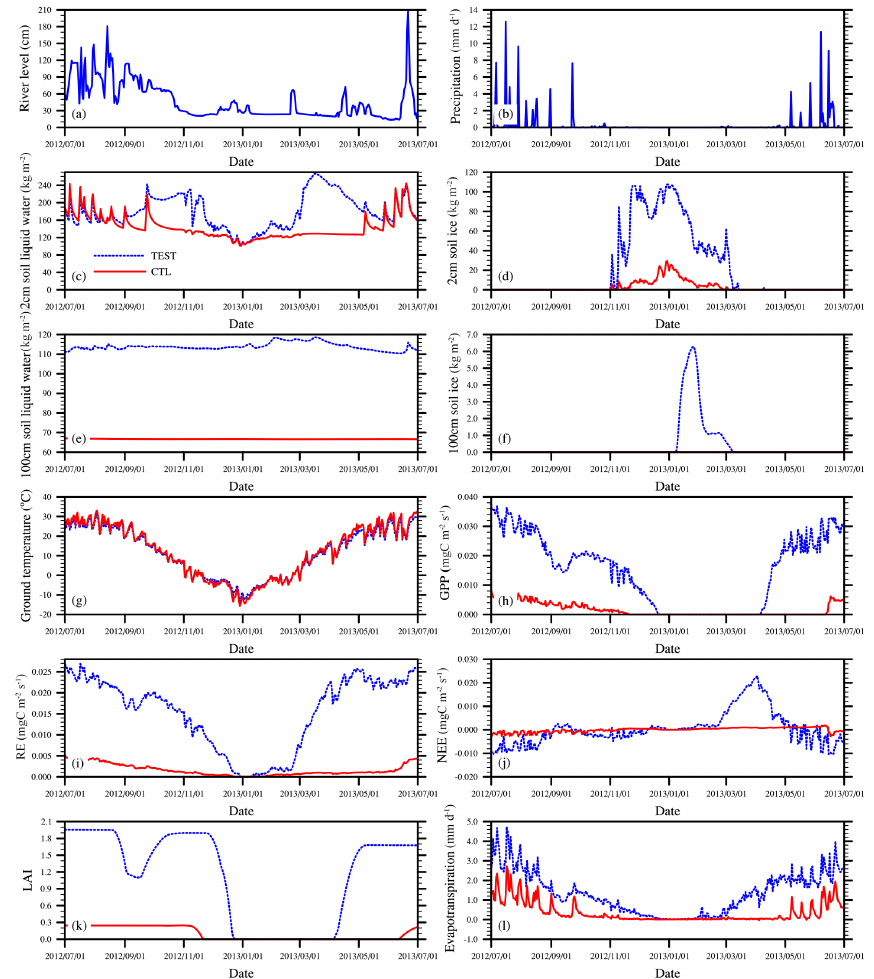
Figure 11. Time series of area-averaged daily (a) observed river level and (b) observed precipitation, as well as (c) 2cm soil liquid water, (d) 2cm soil ice, (e) 100cm soil liquid water, (f) 100cm soil ice, (g) ground temperature, (h) gross primary productivity, (i) respiration efficiency, (j) net ecosystem exchange, (k) leaf area index, and (l) evapotranspiration predicted by TEST and CTL simulations within 300m of both sides of the stream at the Tielu Bridge